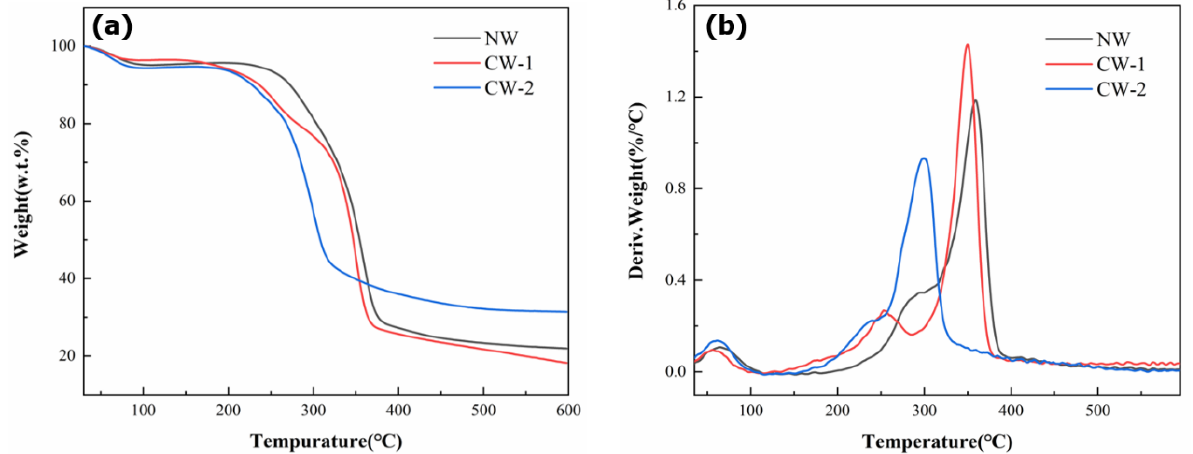
Figure 8. Typical TGA curves ( a ) and DTG curves ( b ) of NW and CW.